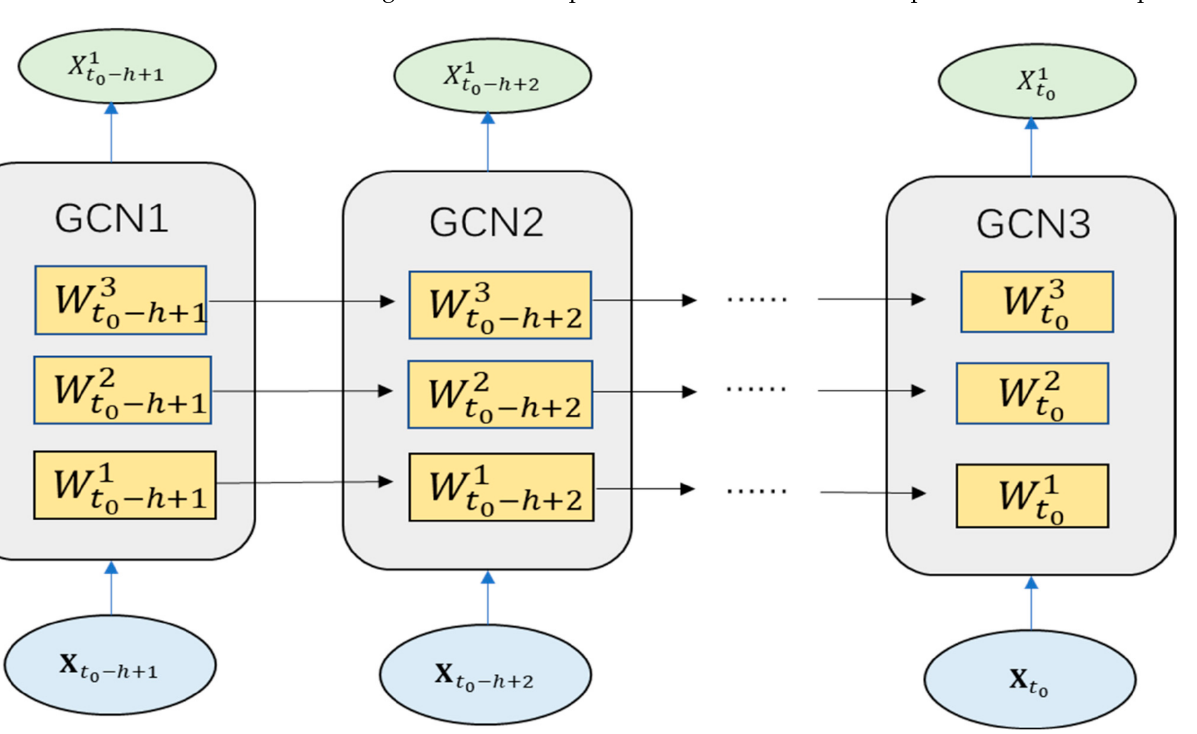
Figure 4. LSTM-GCN block